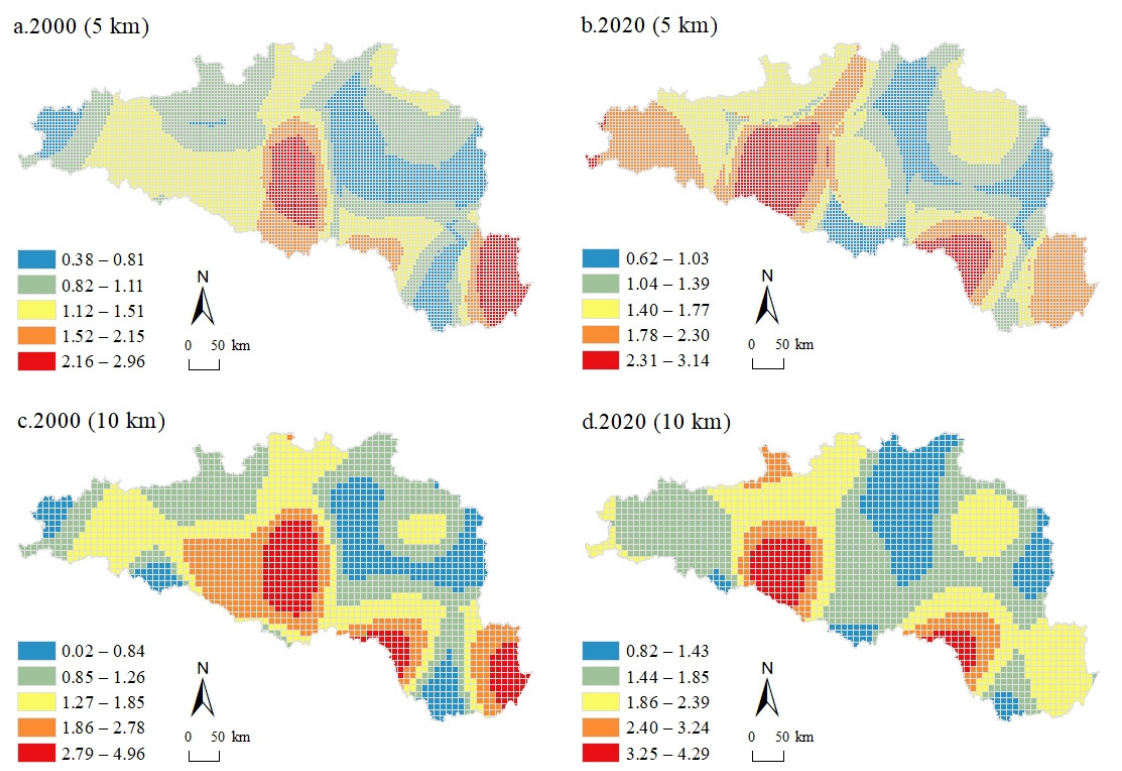
Figure 5. Spatial distribution of the regression coefficients of the effect of UL on CEs at 5 km and 10 km scales in the HREEB in 2000 and 2020.